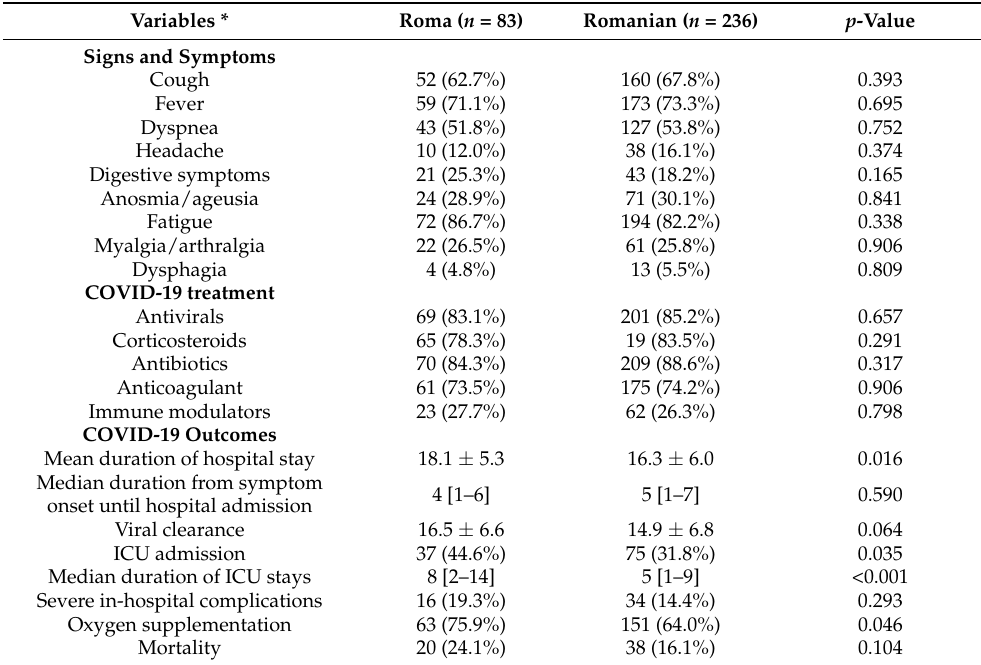
Table 2. Comparison of SARS-CoV-2 infection signs, symptoms, and outcomes between patients of Roma and Romanian ethnicity with severe